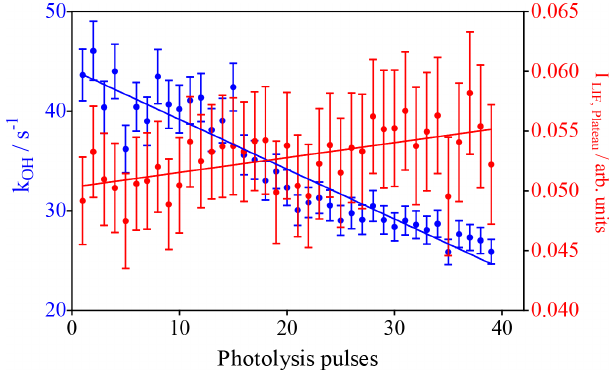
Figure 4. Results of fitting a mono-exponential decay to the raw signal of the experiments shown in Fig. 1. Blue dots: OH decay rates from the mono-exponential fit between 0.02s and the end of the data set (left y axis). Red dots: fluorescence signal after reaction of all OH radicals obtained as plateau of the single-exponential fit (right y axis). Error bars show 95% confidence interval such as that obtained from the